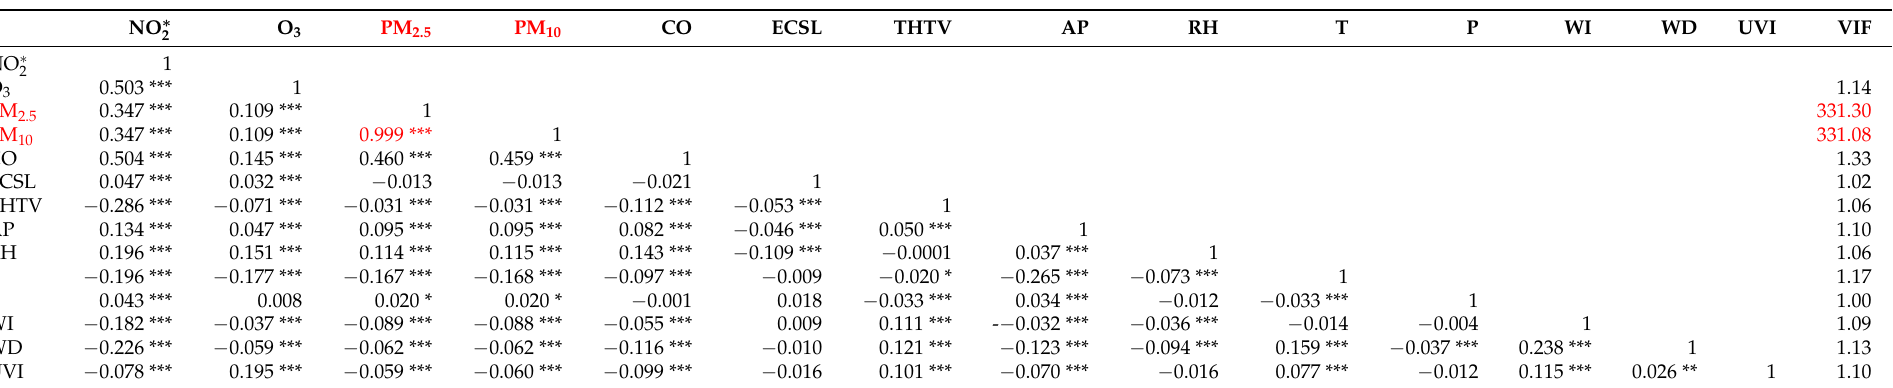
Table 2. Correlation matrix and variable inflation